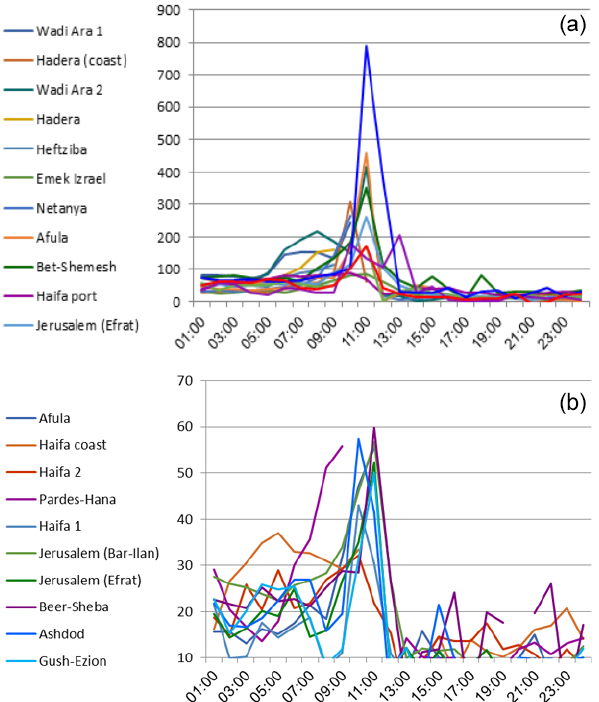
Figure 5. (a) Mass concentration of PM 10 aerosols for several sta- tions in central Israel, 25 October 2015. Data are given in µgm − 3 . Note the peak around 11:00LT, coinciding with the passage of the gust front. The sharp, strong peak was measured at the Rambam Medical Center in Haifa. (b) The same as in (a) , for PM 2 . 5 aerosol concentrations.